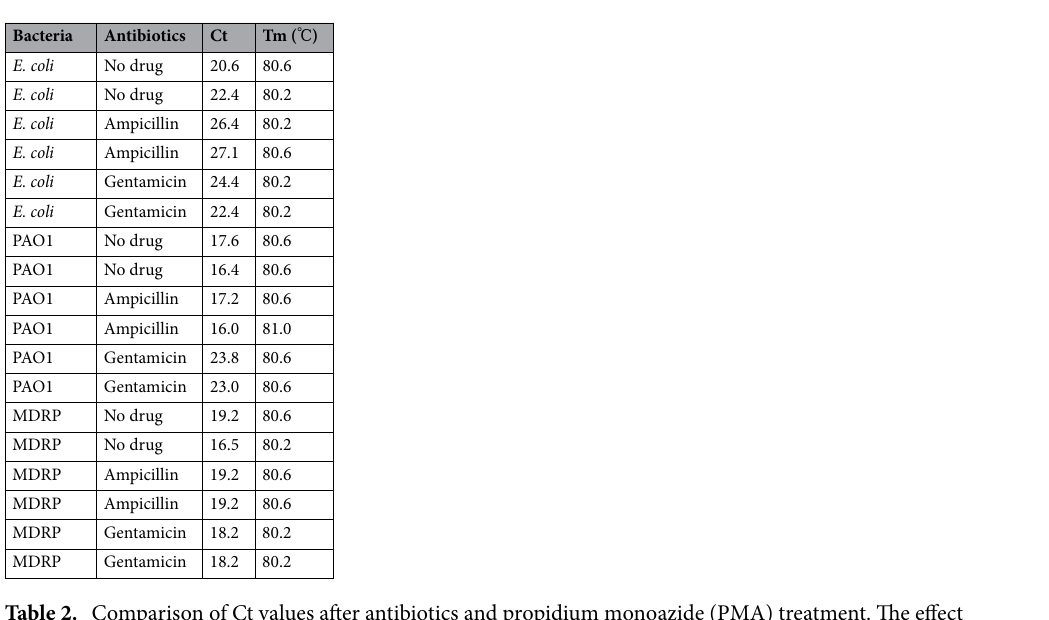
Table 2. Comparison of Ct values after antibiotics and propidium monoazide (PMA) treatment. The effect of PMA was confirmed by comparing the Ct values obtained by real-time PCR. The bacterial genome of each sample was prepared to 3 ng and used for real-time PCR. The results show the proportion of viable bacteria in the 3 ng.